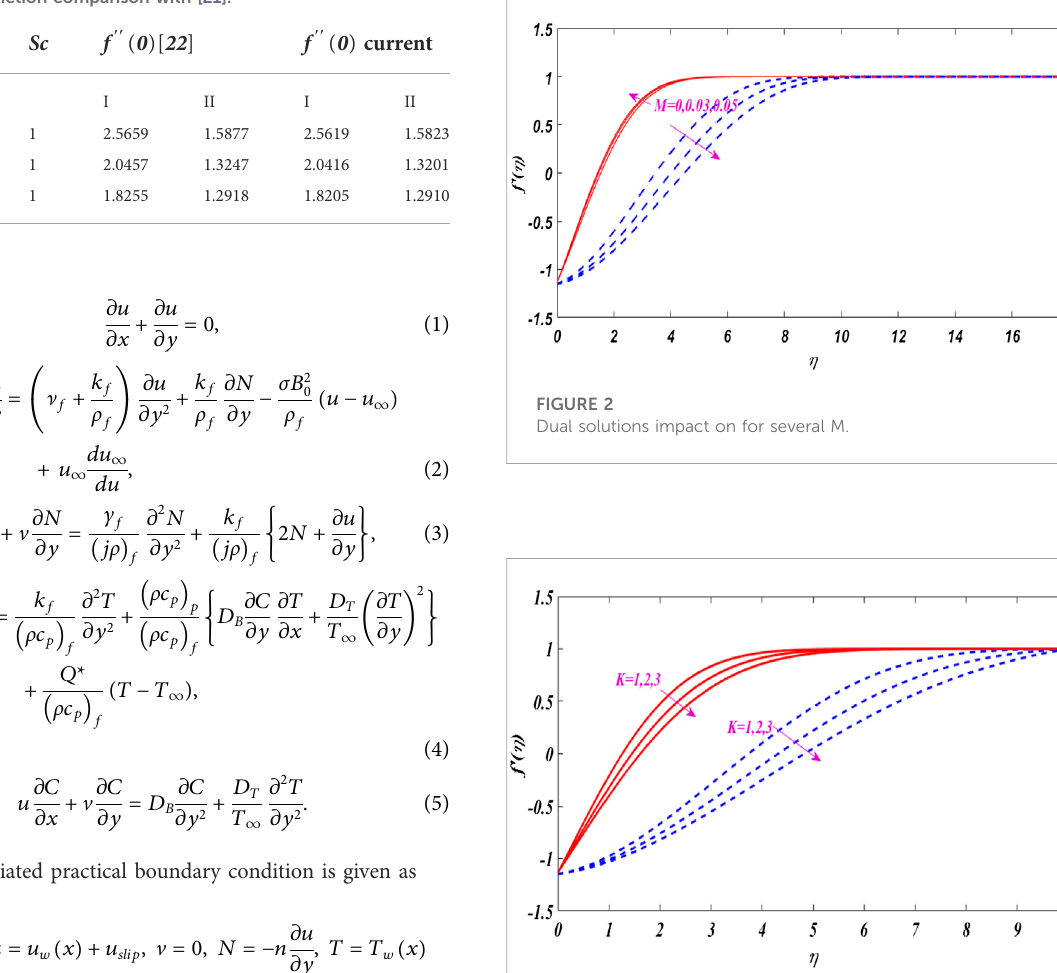
TABLE 1 Skin friction comparison with [21].